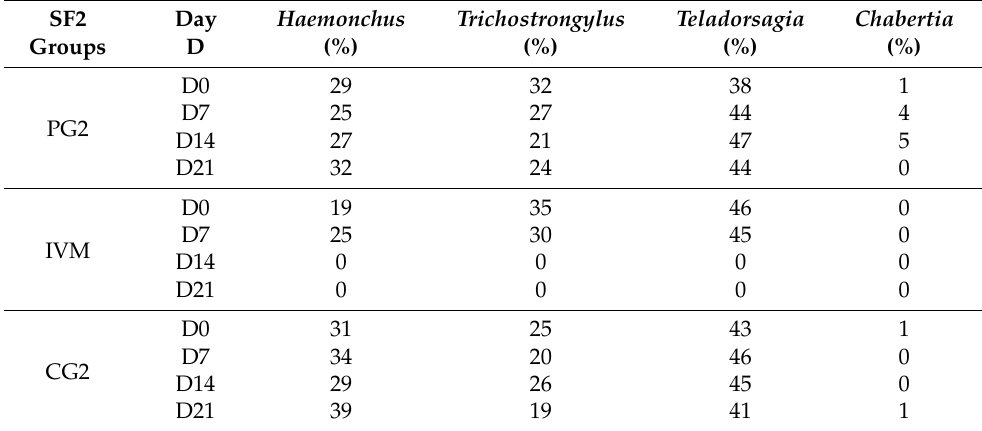
Table 4. Percentage of sheep nematode third-stage larvae (L3) for each group at D0, D7, D14 and D21 in sheep farm 2 (SF2); PG2 Table 2. (50/mL/OS as a single dose); IVM treated Ivermectin group